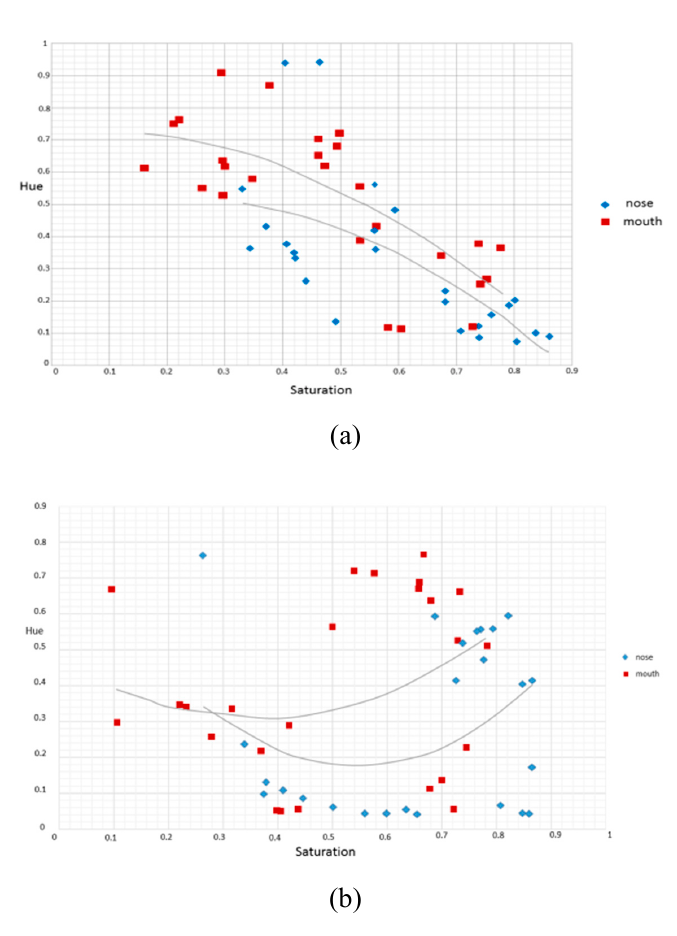
Figure 9. The relation between the saturation and the average hue of the authentic image (left) and the spoofed image (right) using nose (blue) and mouth (red) as examples. ( a ) real image; and ( b ) spoofed